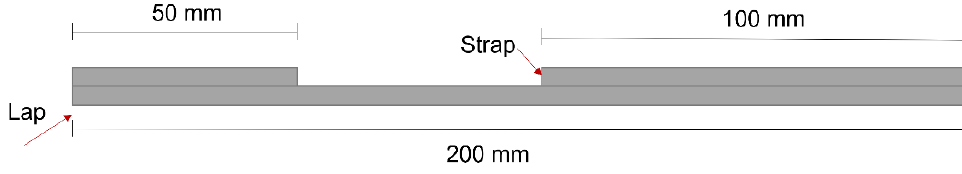
Figure 1. Schematic illustration and dimensions of the lap strap geometry.